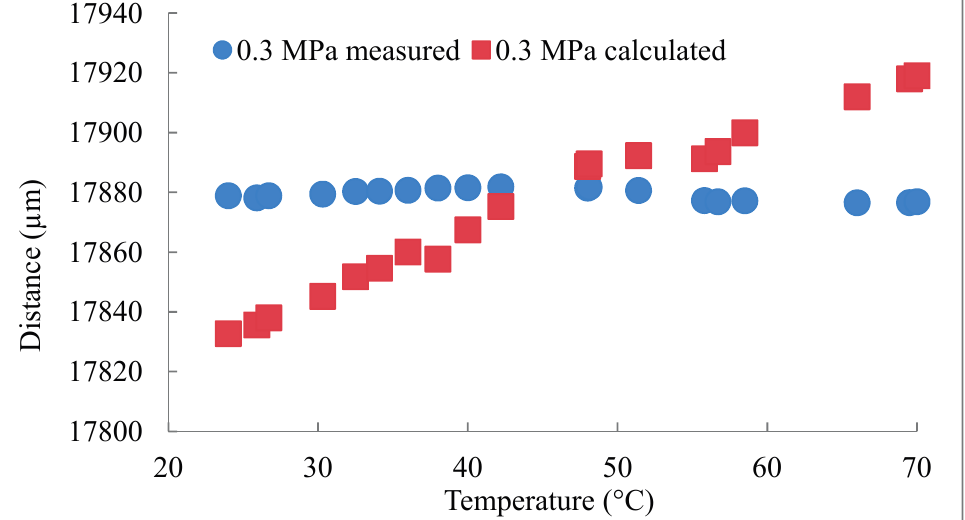
= 2.0 µm, σ = 28.1 measured B&S